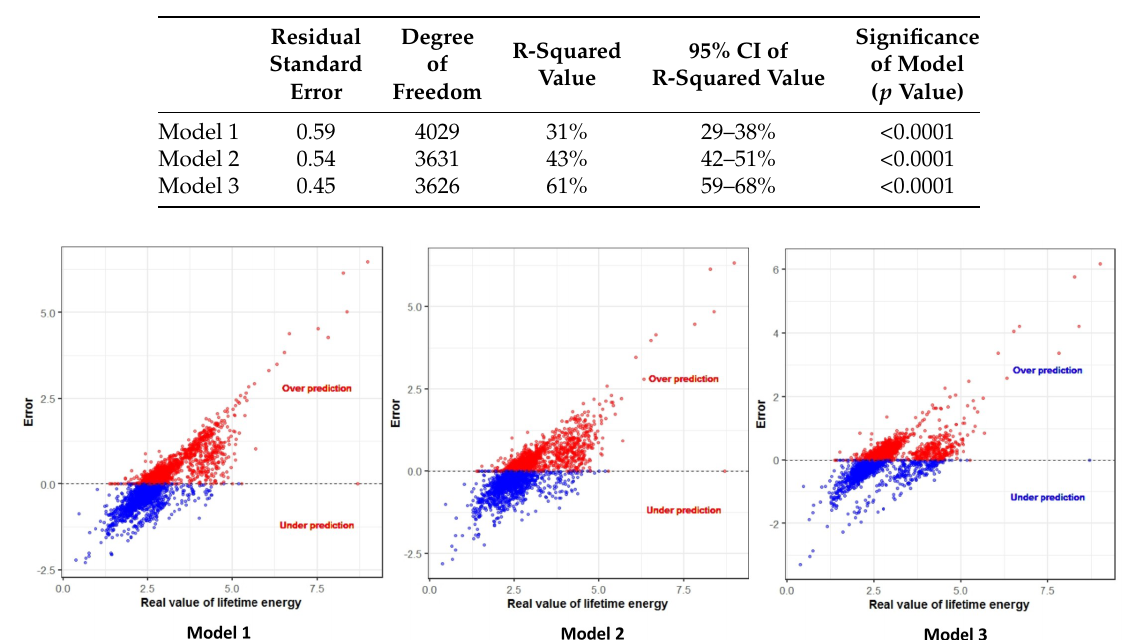
Table 4. The results of multiple linear regression analysis of all PV datasets.